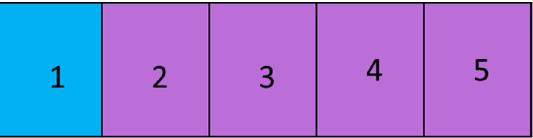
Figure 18. The 5-mod guess based on the 4-mod optimal design. One membrane separator (blue), followed by four membrane reactors (purple).